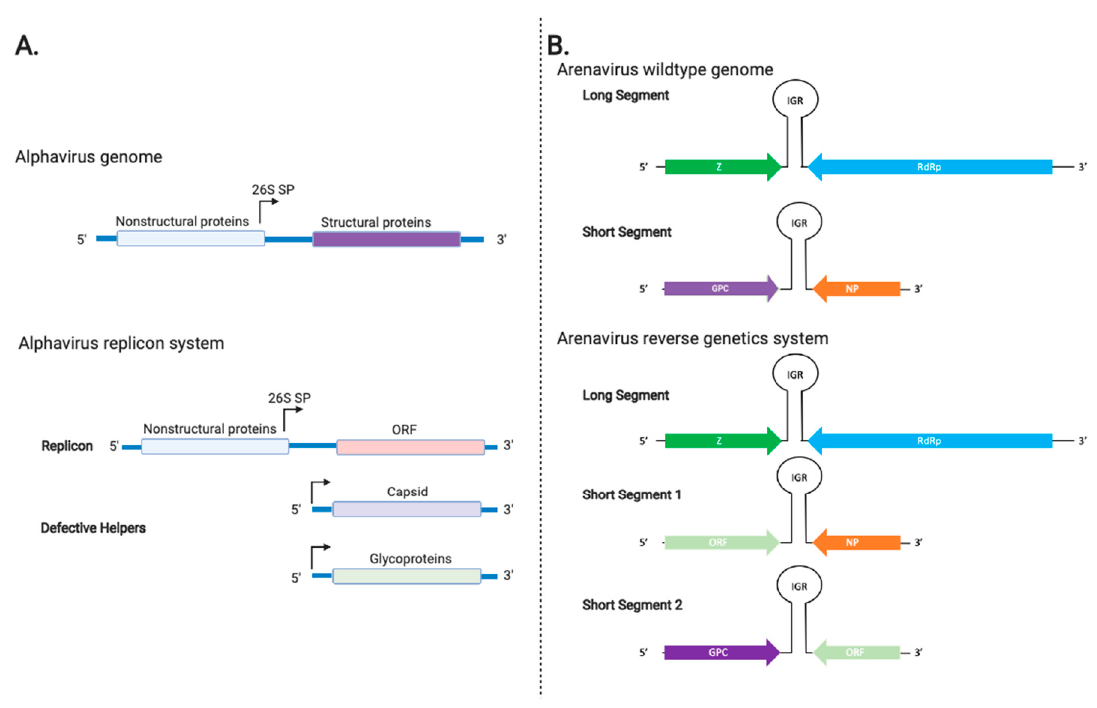
Figure 1. Schematic of alphavirus and arenavirus genomes and the genetic techniques to generate viral vectors from them. ( A ) Wildtype alphavirus genome (top) and its replicon system (bottom). The 26S is the viral subgenomic promoter. ORF: open reading frame ( B ) The wildtype bi-segmented genome of arenaviruses (top) and the reverse genetics system to generate the arenaviral tri-segmented genome (bottom). The ambisense genome contains the glycoprotein precursor complex (GPC), the nucleoprotein (NP), the matrix (Z), and the RNA-dependent RNA polymerase (RdRp). A noncoding intergenic region (IGR) separates the two genes, which are transcribed in opposite directions. Created with Biorender.